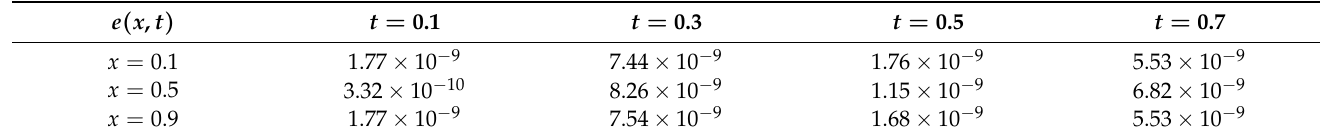
Table 2. Absolute error of each point when α = 0.5.